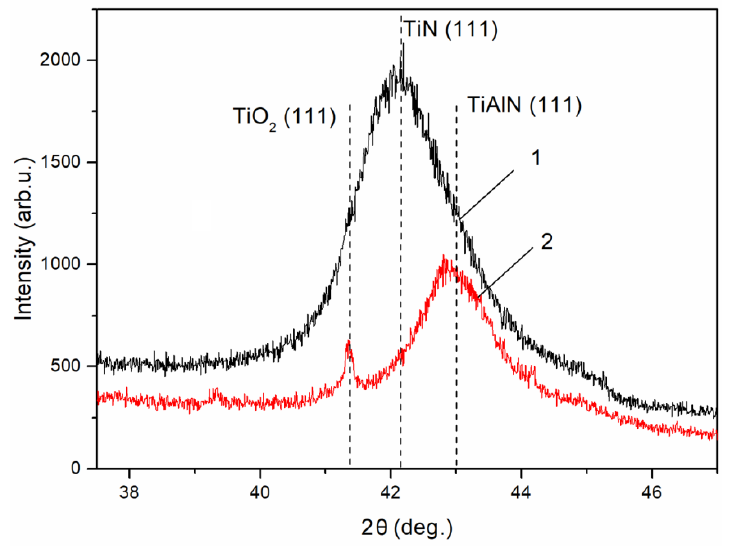
Figure 12. SXRD patterns of the Ti 0.61 Al 0.39 N coating obtained before (1) and after (2) heating to 1300 °C.